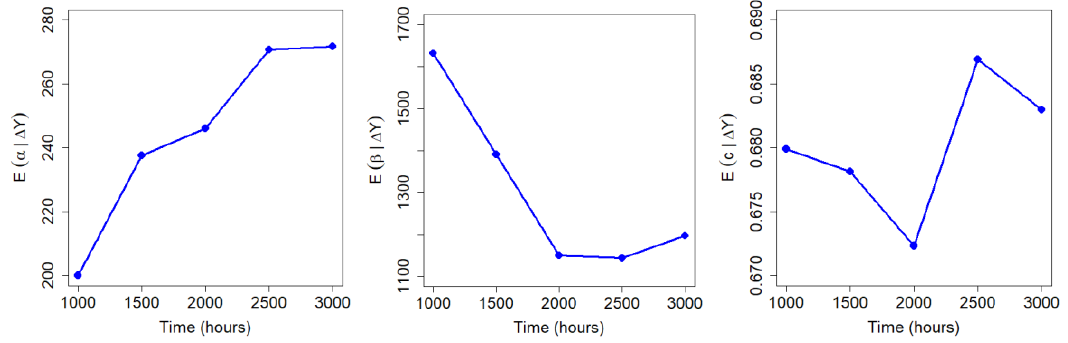
Figure 3. Updates of posterior mean of parameters α , β , and c with